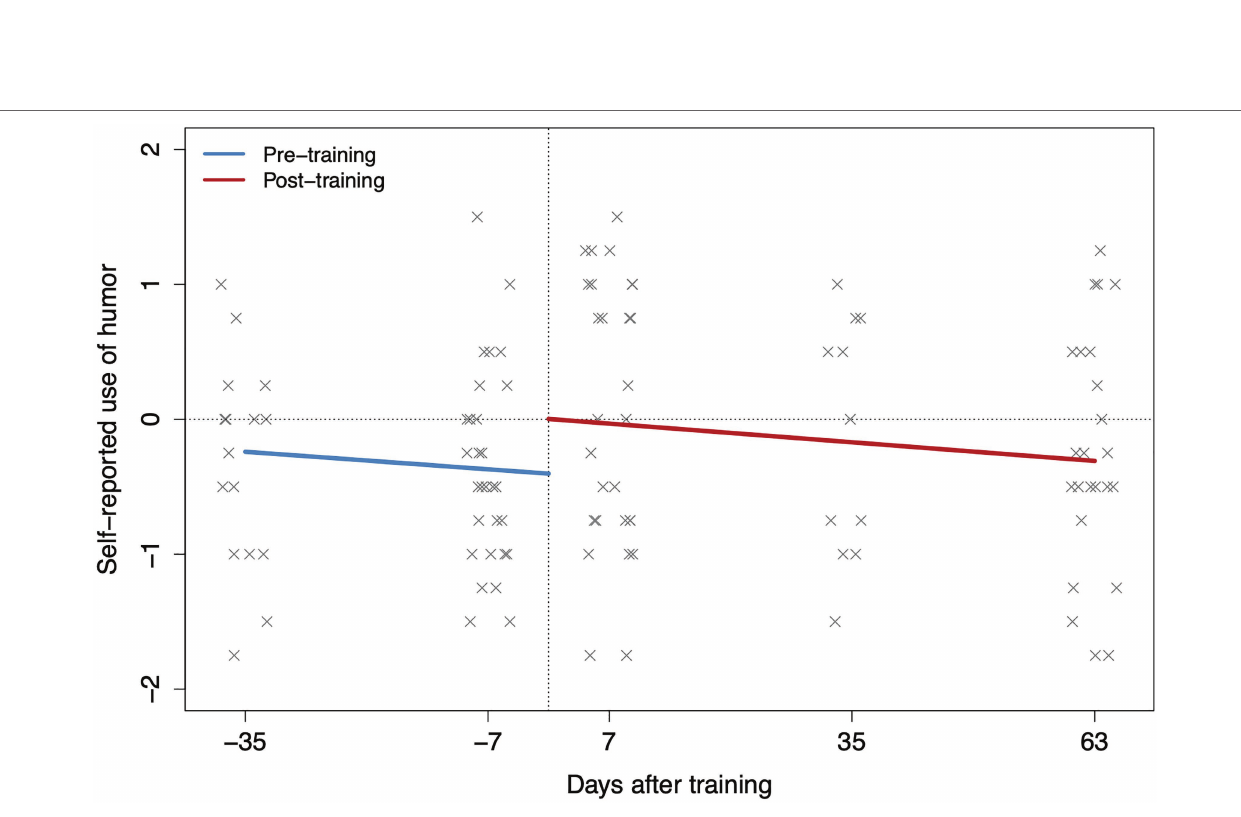
FIGURE 5 | Positive ER training effects over time on use of humor for all the available time points of the entire